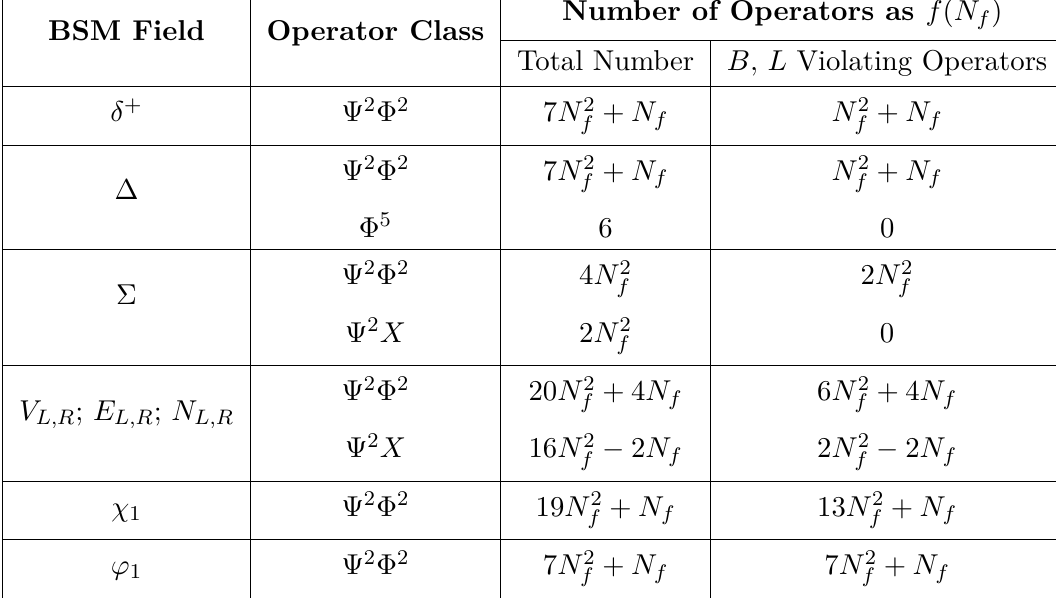
Table 28 . Number of additional operators of different classes at dimension 5 with N f fermion flavours for each BSM model. There are no new dimension 5 operators for the models containing ρ ++ and X µ , Y µ